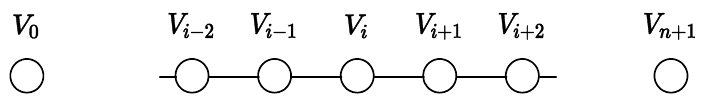
Figure 1. Linear Wireless Sensor Networks.